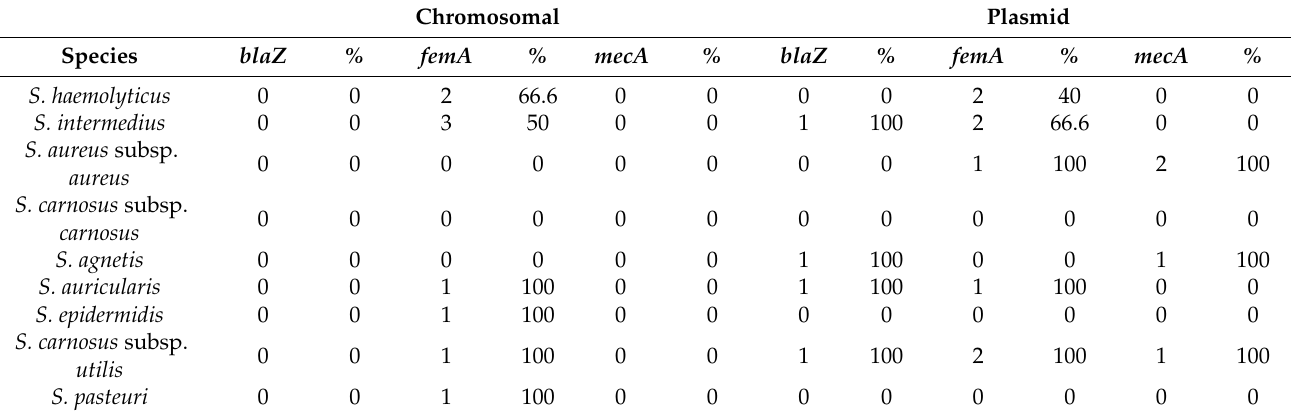
Table 3. Isolates resistant to penicillin G and positive for the genes blaZ , femA , and mecA . Chromosomal